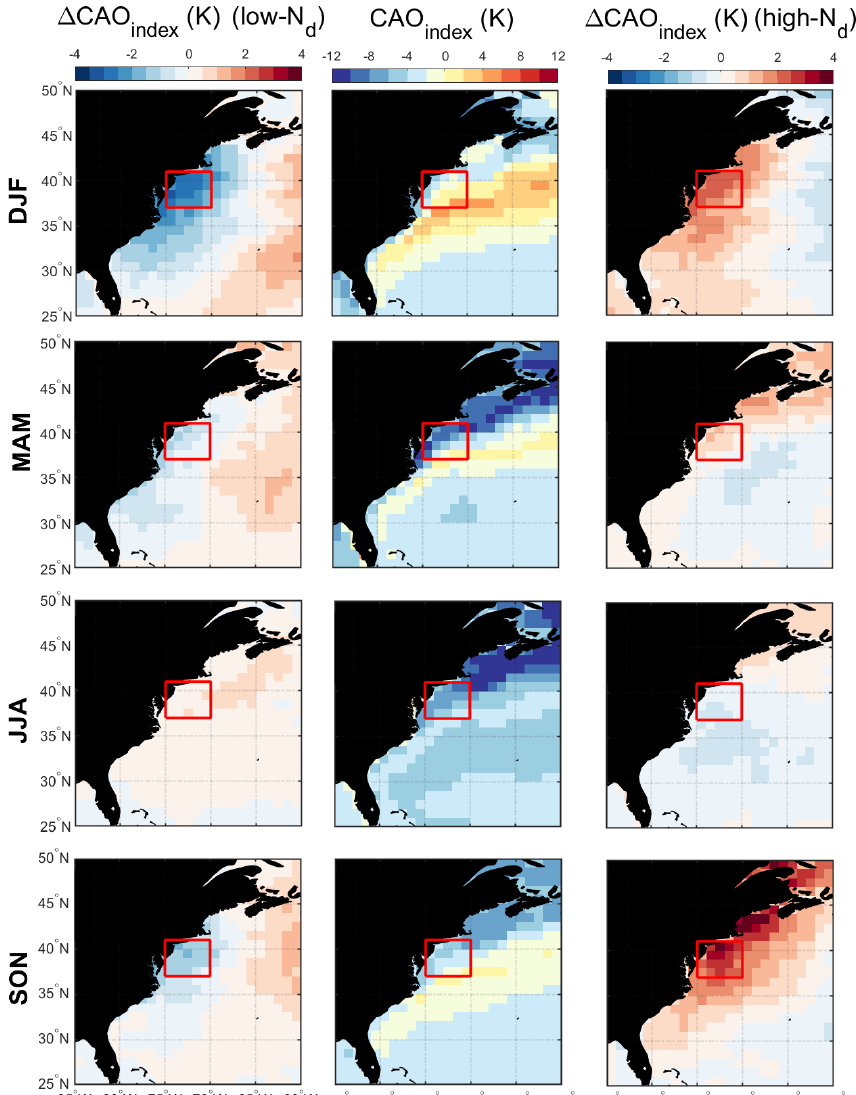
Figure 11. Seasonal averages of cold-air outbreak (CAO) index (middle column) and associated anomalies on low- N d days (left column) and high- N d days (right column). The red box represents sub-domain C-N for which the analysis was